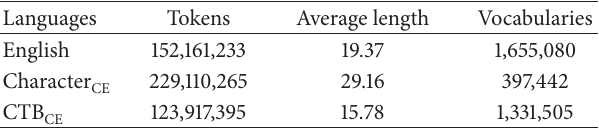
Table 7: Statistics of CMWT 2013 +